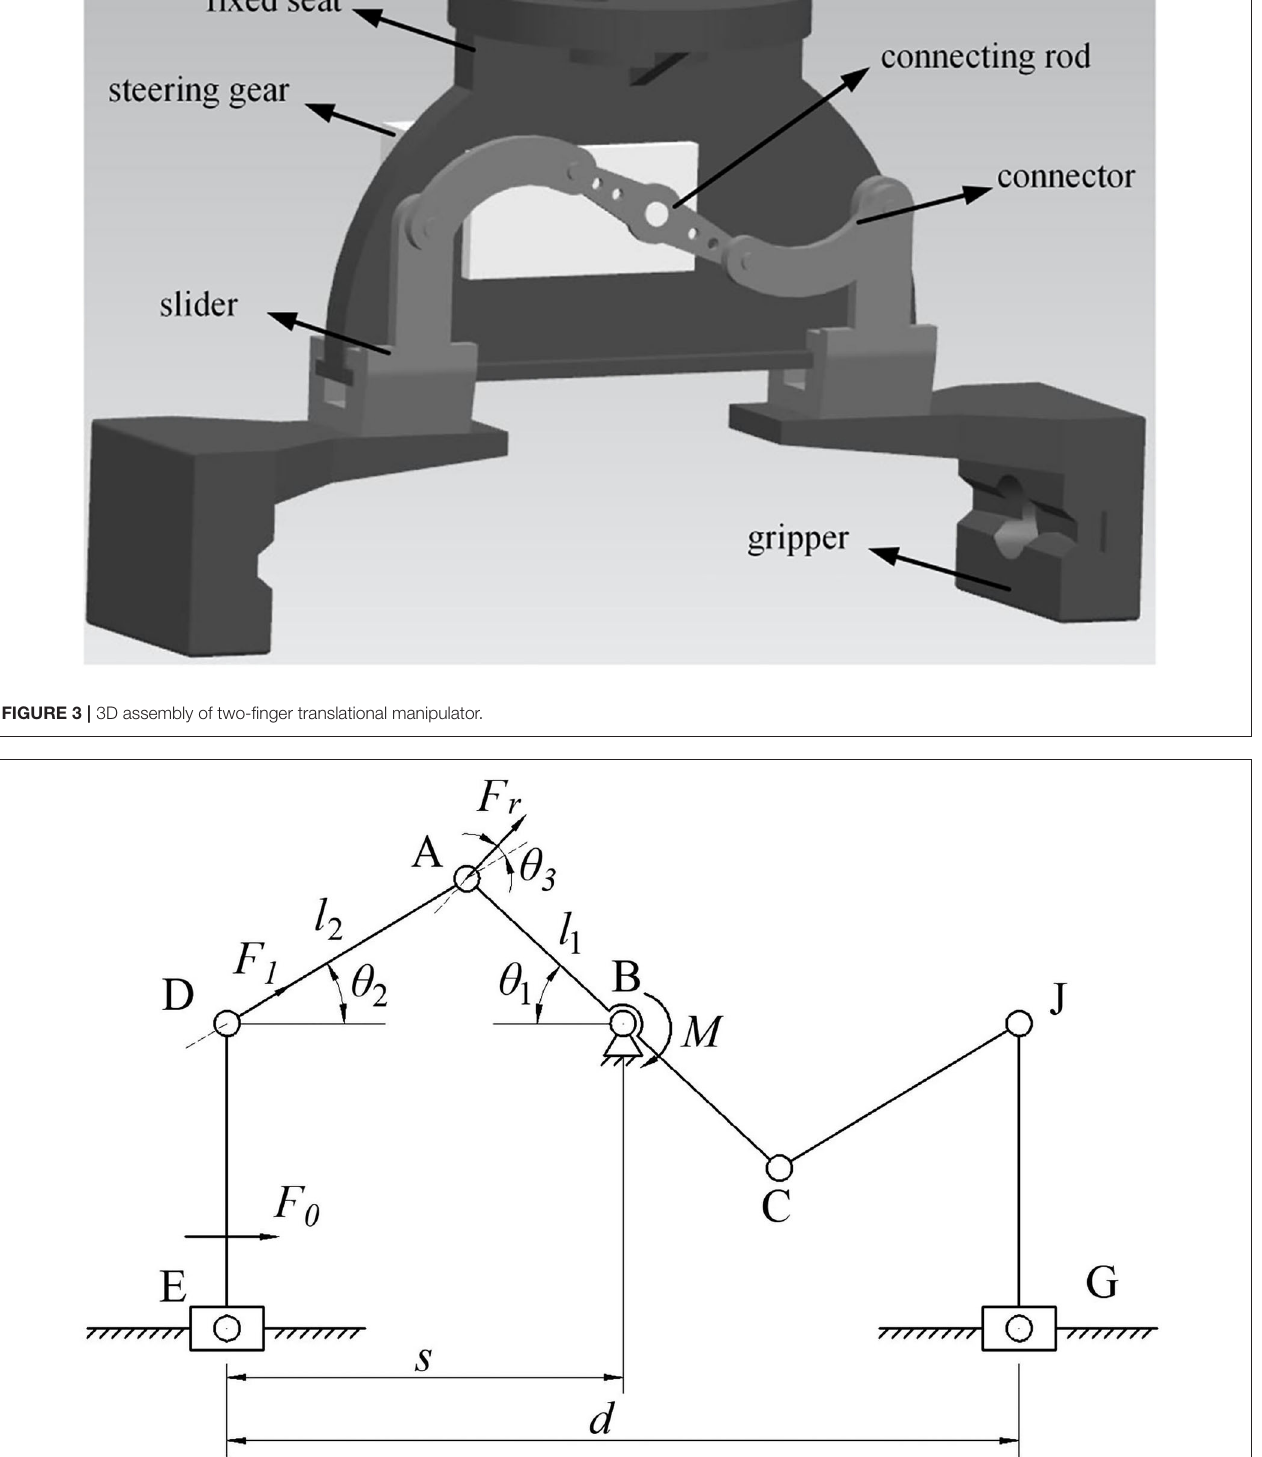
Frontiers in Neurorobotics |